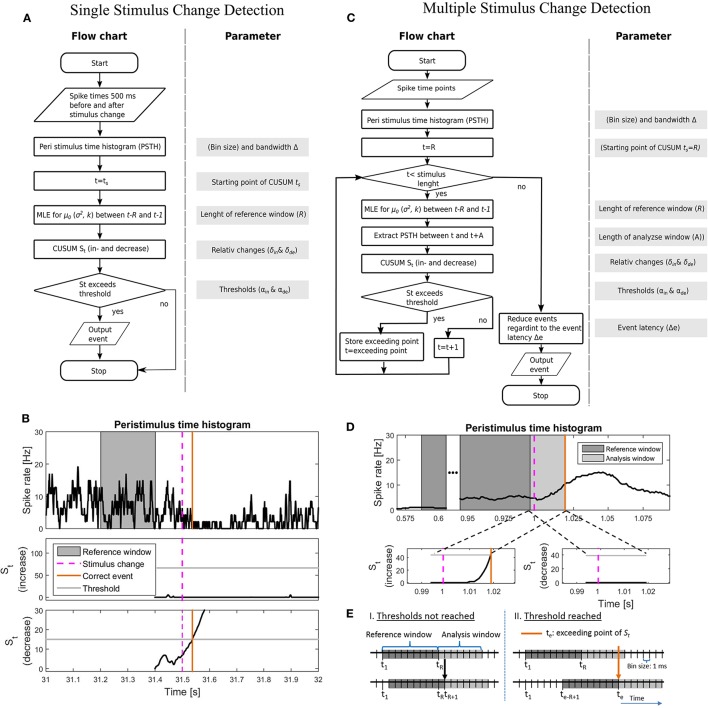
Illustration of the implementations of the CUSUM approach for the single (A,B) and multiple (C–E) stimulus change detection procedures. (A) Flowchart and a list of parameters for the single stimulus change detection. The parameters are listed in Table 4A. (B) An example of the implementation for single stimulus change detection on the example for the Gaussian additive model. Values of the parameters are shown in Table 4A. (Top) PSTH with a reference window, stimulus change and correct detected event; (middle) Cumulative sum St for the increased activity with threshold αin; (bottom) Cumulative sum St for the decreased activity with threshold αde. Both cumulative sums were calculated in parallel. (C) Flowchart and included parameters for the single stimulus change detection. The parameters are listed in Table 4B. In (A,C), MLE stands for maximum likelihood estimation. (D) An example of the implementation for multiple stimulus change detection on the example for the Gaussian additive model. The parameter values are shown in Table 4B; (Top) PSTH with reference window, analysis window, stimulus change and correct detected event; (bottom-left) Cumulative sum St for the increased activity with threshold αin; (bottom-right) Cumulative sum St for the decreased activity with threshold αde. Both cumulative sums were calculated in parallel. PSTH for the multiple change detection (D) was smoother than that for the single change detection (B), because of the longer PSTH bandwidth Δ after optimization (single: 5 ms; multiple: 40 ms, see Table 4). (E) Visualization of how to shift the reference window. I. if the cumulative sum St did not reach any threshold (αin, αde) or II. if a threshold was reached.